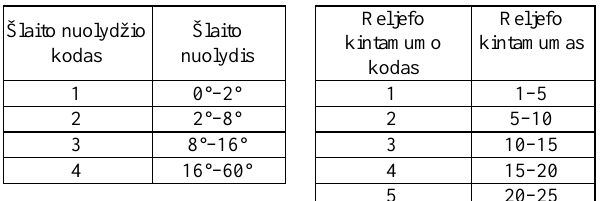
Table 1. Relief slope and variability